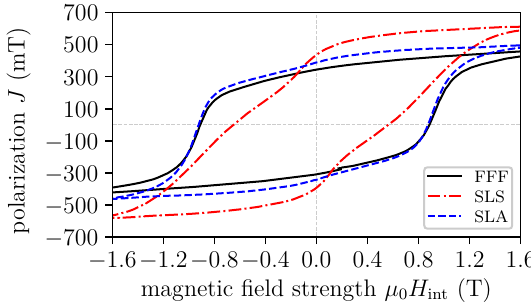
Figure 3. Hysteresis loops of the different printing methods.